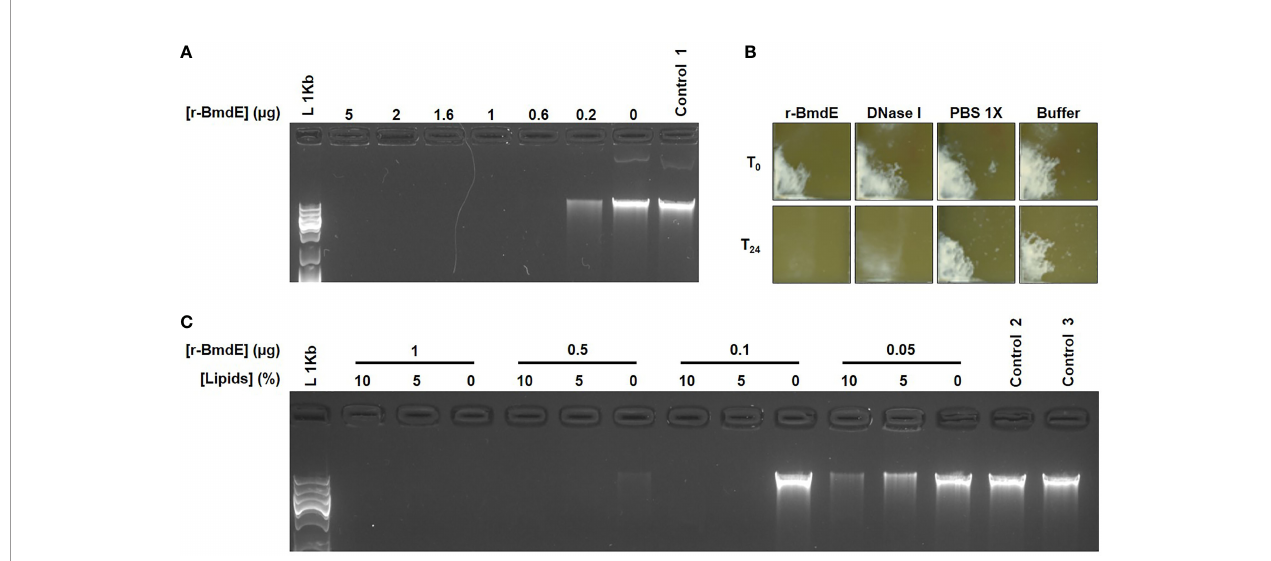
FIGURE 2 | In vitro deoxyribonuclease activity of r-BmdE. (A) P. acnes DNA treated with r-BmdE. Control 1 consisted of r-BmdE buffer at the highest volume. (B) Mature bio fi lm of P. acnes incubated r-BmdE. An equal molar ratio of DNase I (0.0003 mg/mL) was used as a positive control and 10 µL of PBS 1X and r-BmdE buffer were used as negative controls. (C) r-BmdE activity in lipids. Controls 2 and 3, consisted of r-BmdE buffer and water